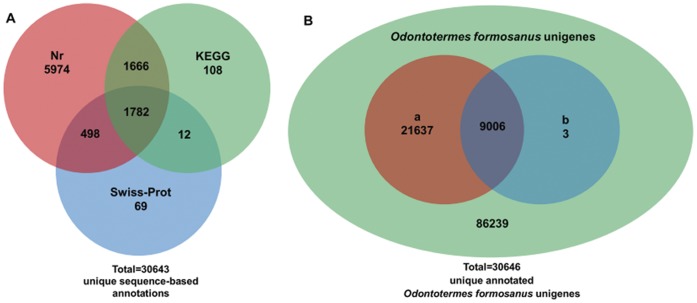
Distribution of similarity search results showed by Venn diagrams.(A) The number of unique sequence-based annotations is the sum of unique best BLASTX hits from the nr, Swiss-Prot and KEGG databases (E-value≤1.0E-5), respectively. The overlap regions among the three circles contain the number of unigenes that share BLASTX similarity with respective databases. (B) Number of all annotated Odontotermes formosanus unigenes is figured out based on the summation of both unique sequence-based annotations and unique domain-based annotations. The circle “a” and “b” indicate the two subsets of O. formosanus unigenes with sequence-based annotations and domain-based annotations, respectively.